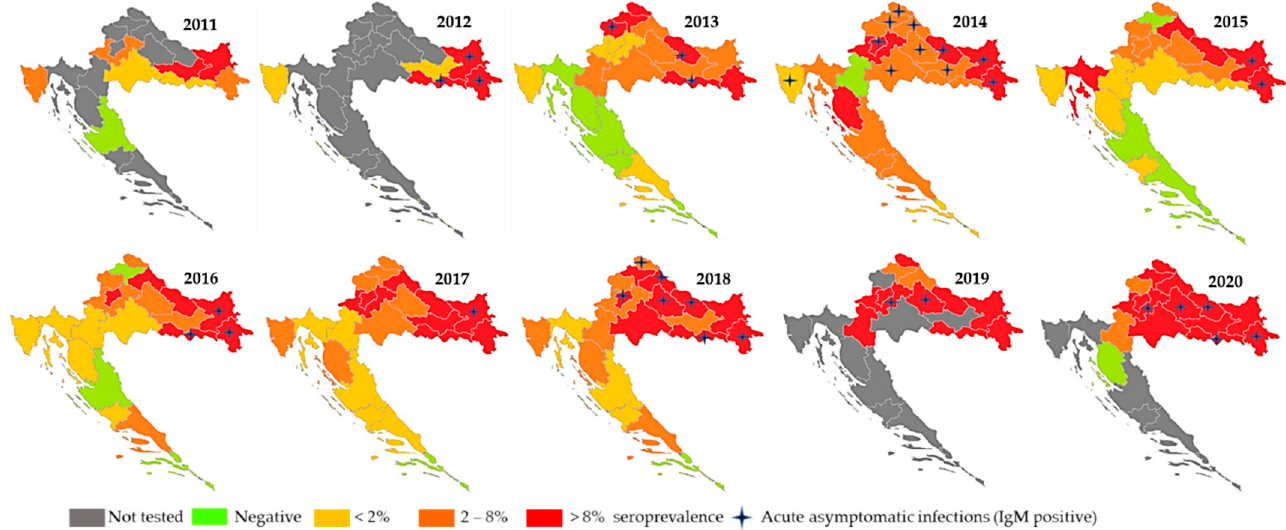
Figure 3. WNV infections in horses, 2011–2020.